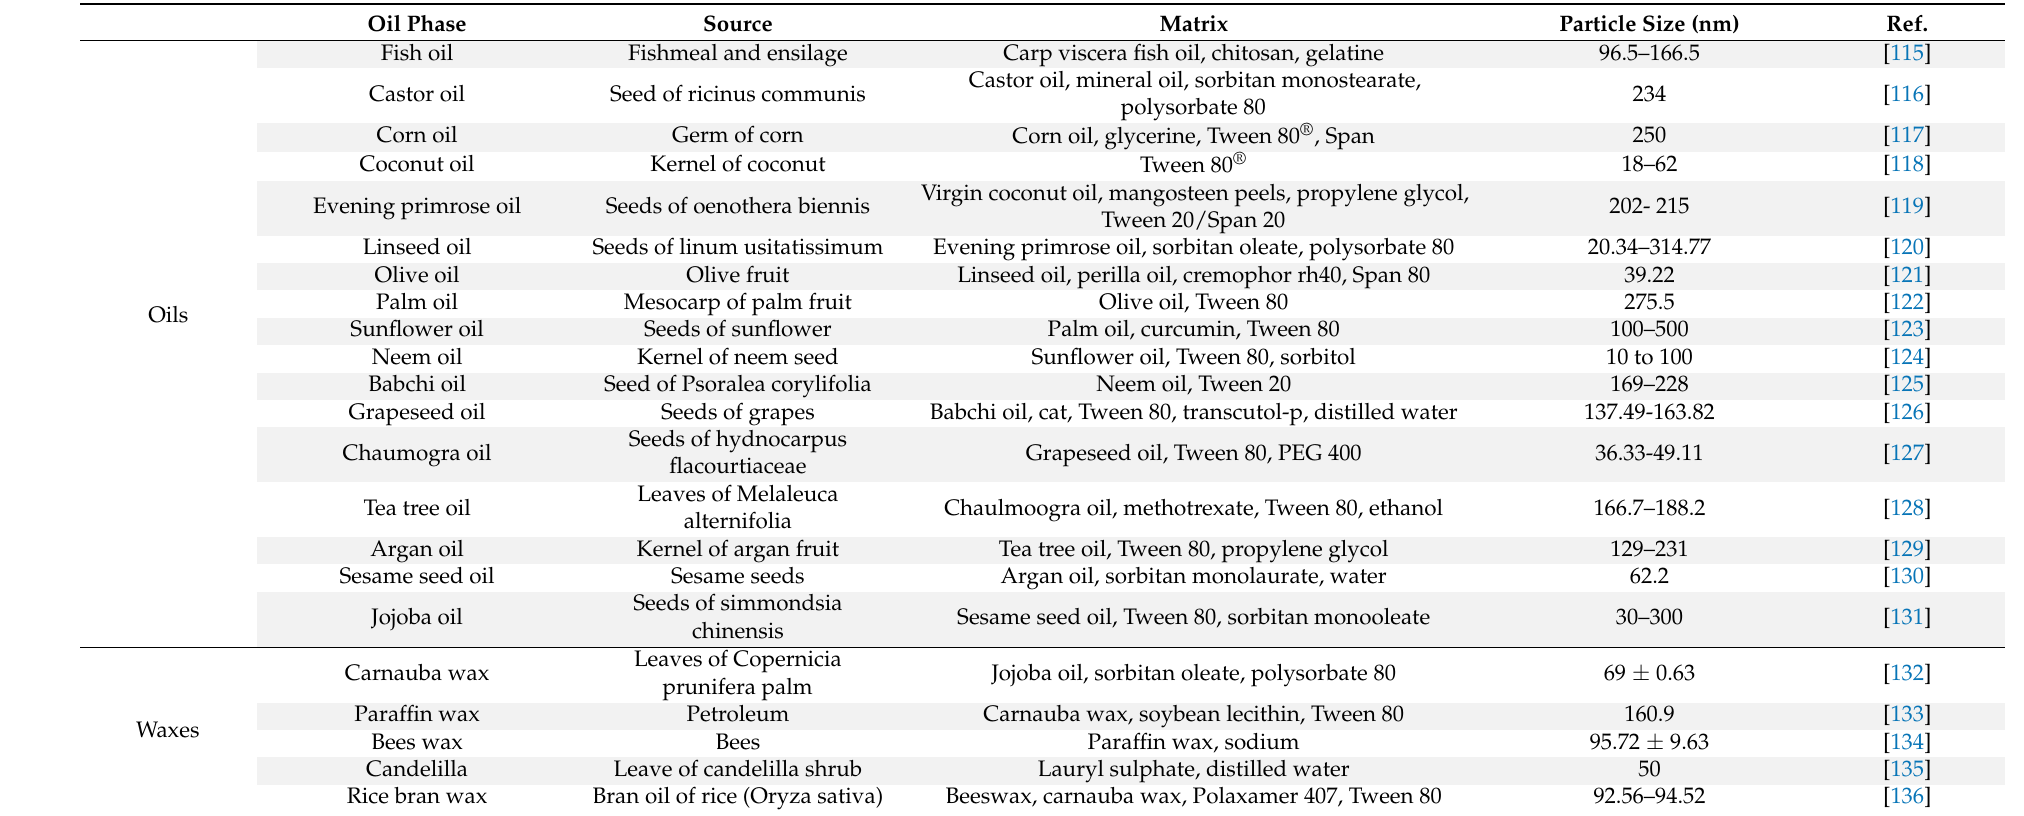
Table 2. Suggestive list of oil phases to be used in